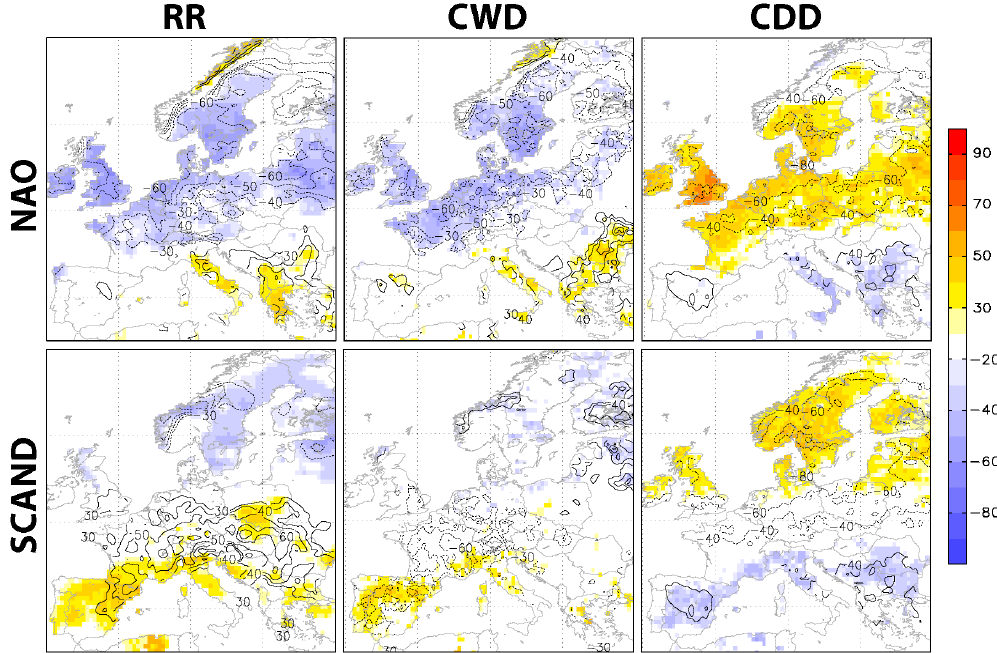
Fig. 7. Shaded regions represent the correlation coefficients ( × 100) between the teleconnection indices (NAO, SCAND, by rows) and the mean or extreme precipitation fields (by columns) in summer. Contour lines represent the EOF associated with the PC better correlated with the teleconnection index according to Table 4.